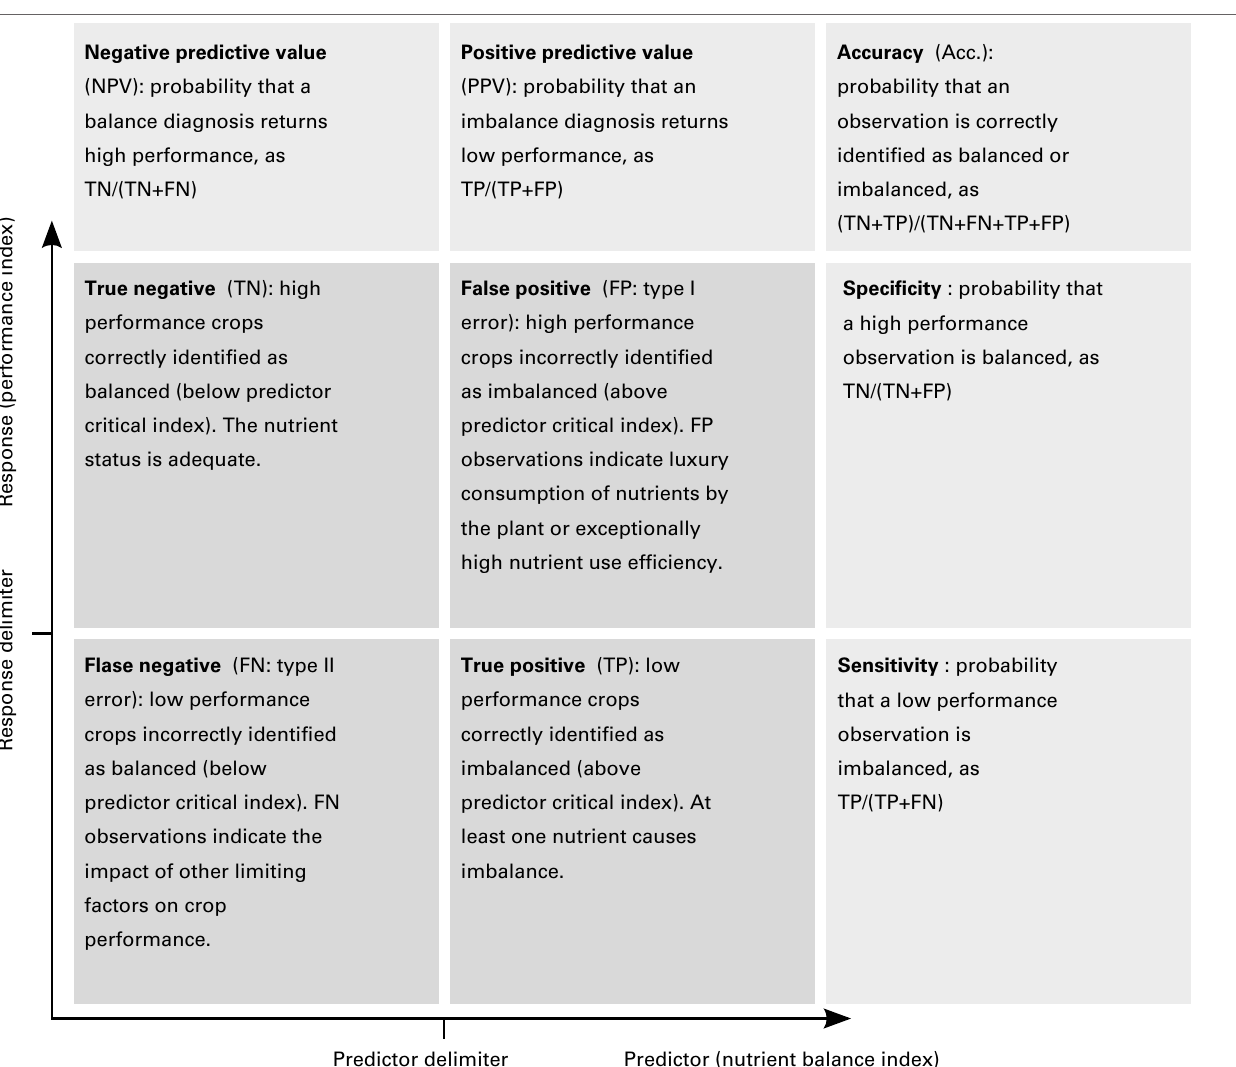
Table 2 | Term definitions in binary